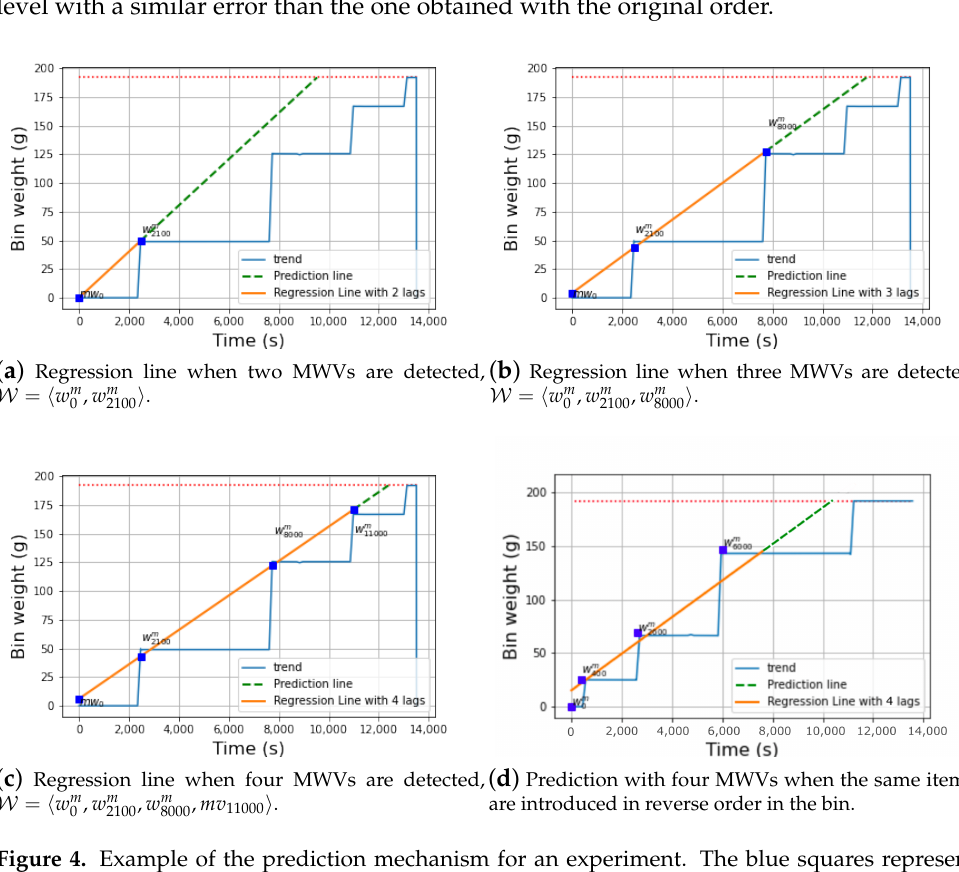
Figure 4. Example of the prediction mechanism for an experiment. The blue squares represent MWVs. The horizontal dotted red line indicates the maximum weight of the bin w max